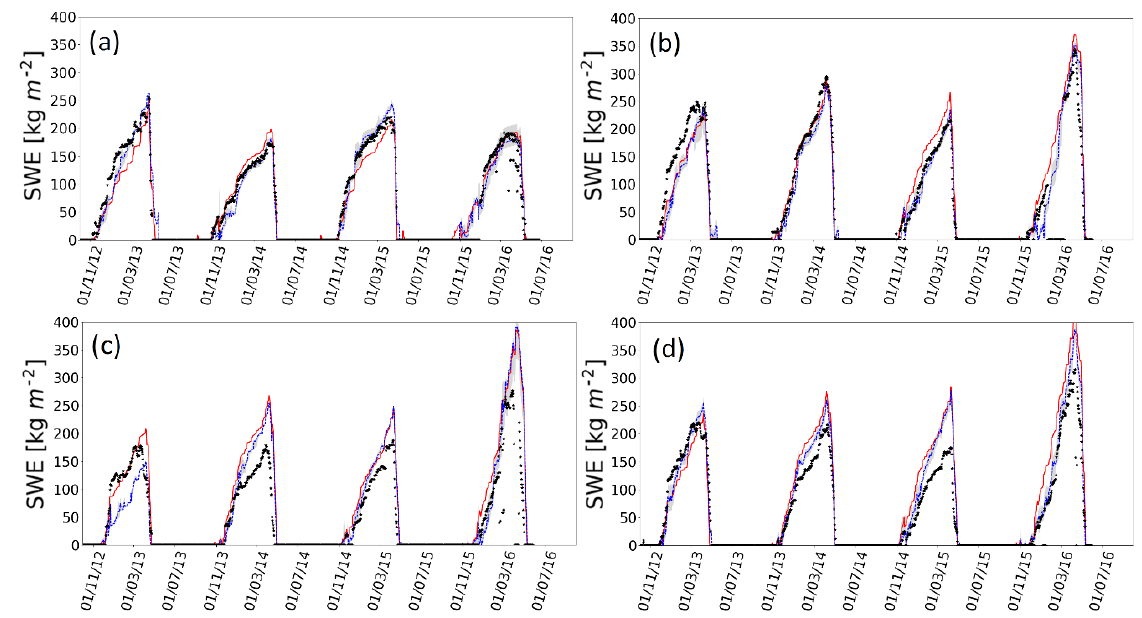
Figure 7. Evolution of SWE measurements (black points), original SWE simulations (red full line), and the median of the SWE ensemble obtained with the DA_b_TB_11,19,37 experiment (SWE DA ) (blue dotted line). The gray envelope is the spread of the SWE DA ensemble (posterior estimates). Experiments are computed for (a) Site 5 ( f cover = 31 . 5%), (b) Site 1 ( f cover = 63 . 7%), (c) Site 9 ( f cover = 84%), and (d) Site 10 ( f cover = 61 . 8%), from 2012 to